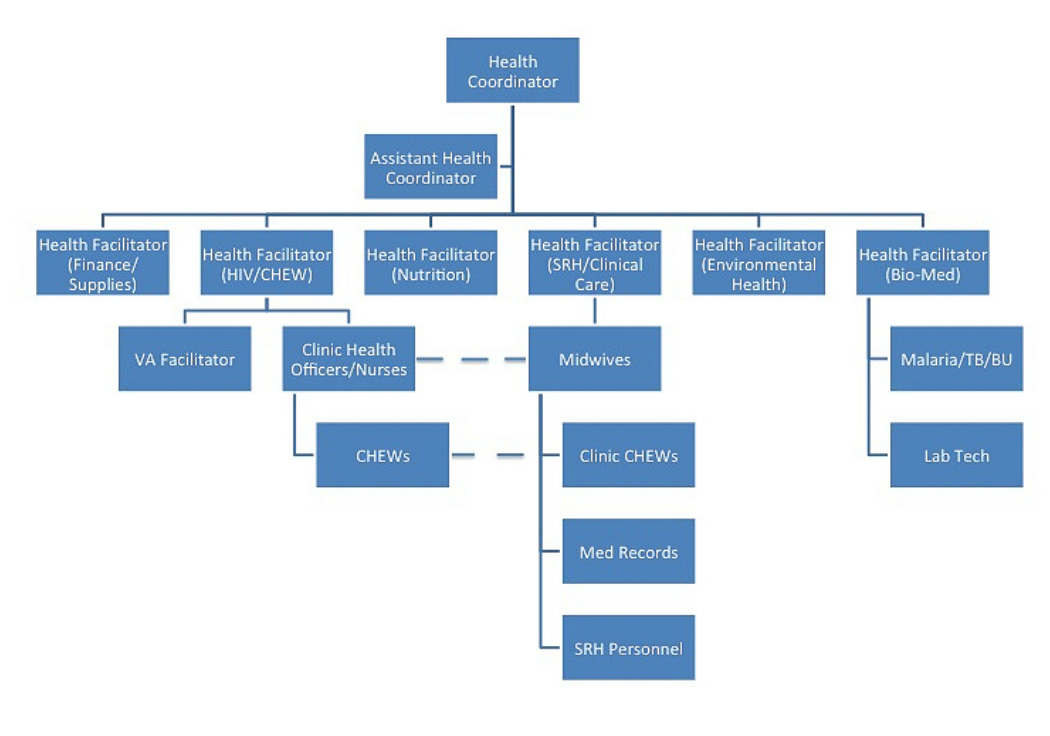
Figure 2. Color key for sociograms made in NetDraw on the traditional organizational structure and monthly Airtel closed user group call